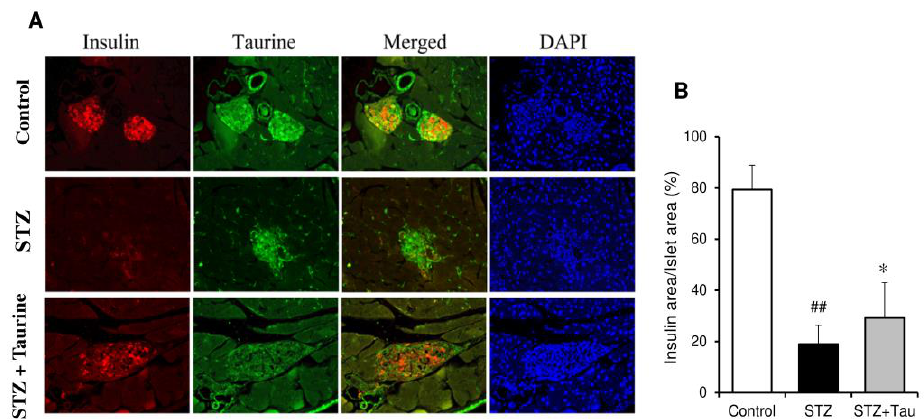
Figure 9. Effects of taurine supplementation on the insulin and taurine levels in pancreas of diabetic mice. Double immunofluorescence staining for taurine and insulin was performed in the pancreas ( A ). The areas of insulin-positive cells were measured, and the percentage in the islets was calculated ( B ). Each value is expressed as the mean ± S.D. ( n = 24), ## p < 0.01 vs Control group, * p < 0.05 vs STZ group.